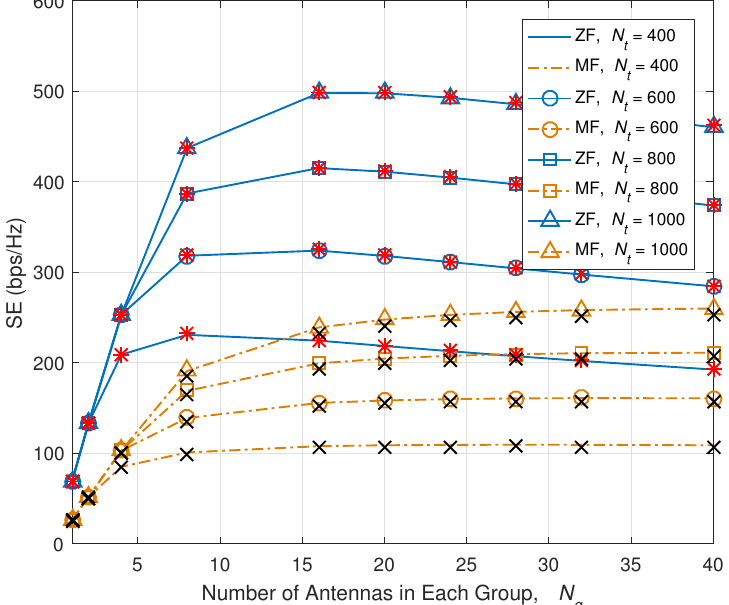
Figure 7. SE versus number of antennas in each group, N g . Red ‘*’s and black ‘x’ indicate the simulation results.